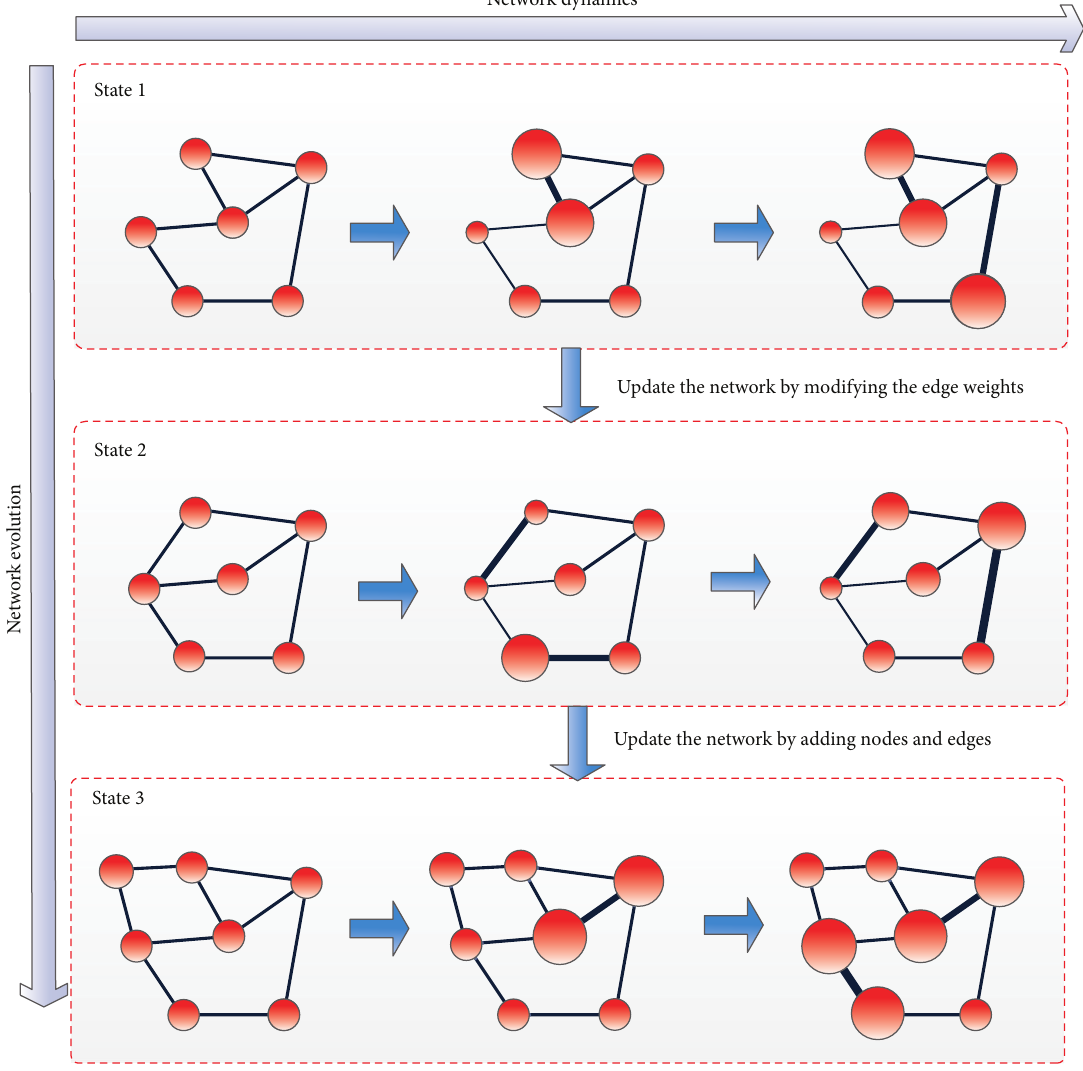
Figure 1: Illustration of the network evolution.